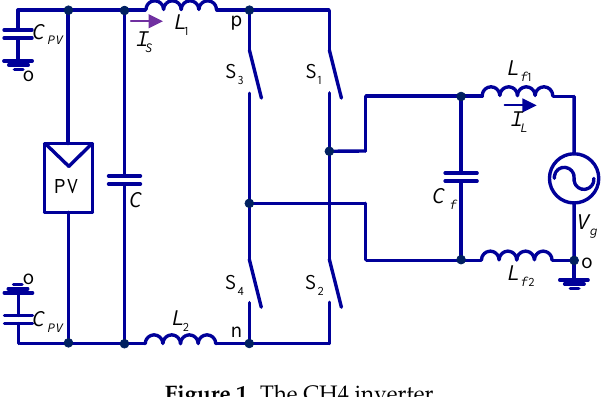
Figure 1. The CH4 inverter.